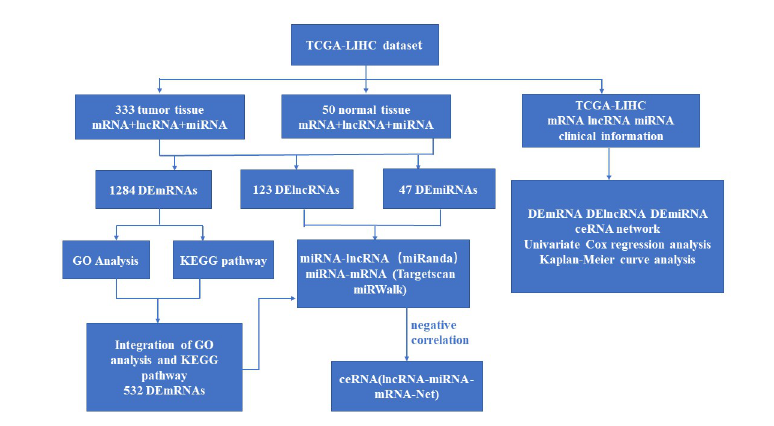
Fig 1. Flowchart of bioinformatics analysis for LIHC data from TCGA